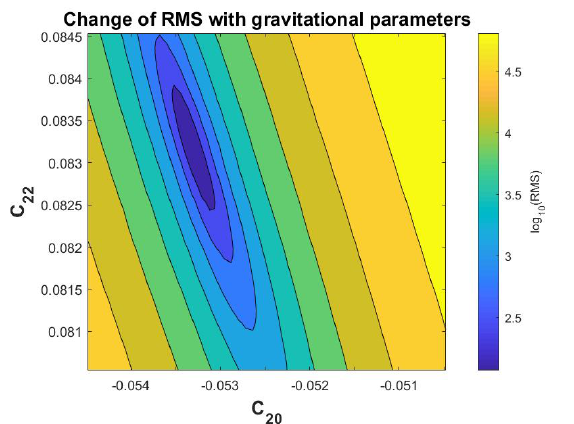
Figure 5. Contour map of the residual with respect to the gravity-field coefficients C 20 and C 22 (erroneous initial